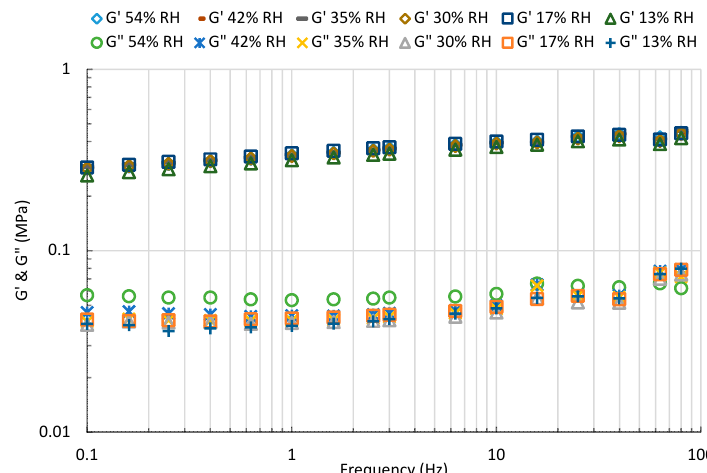
Figure 13. Storage modulus (G’) and Loss modulus (G”) of starch-beet pulp foams at different RH conditions.